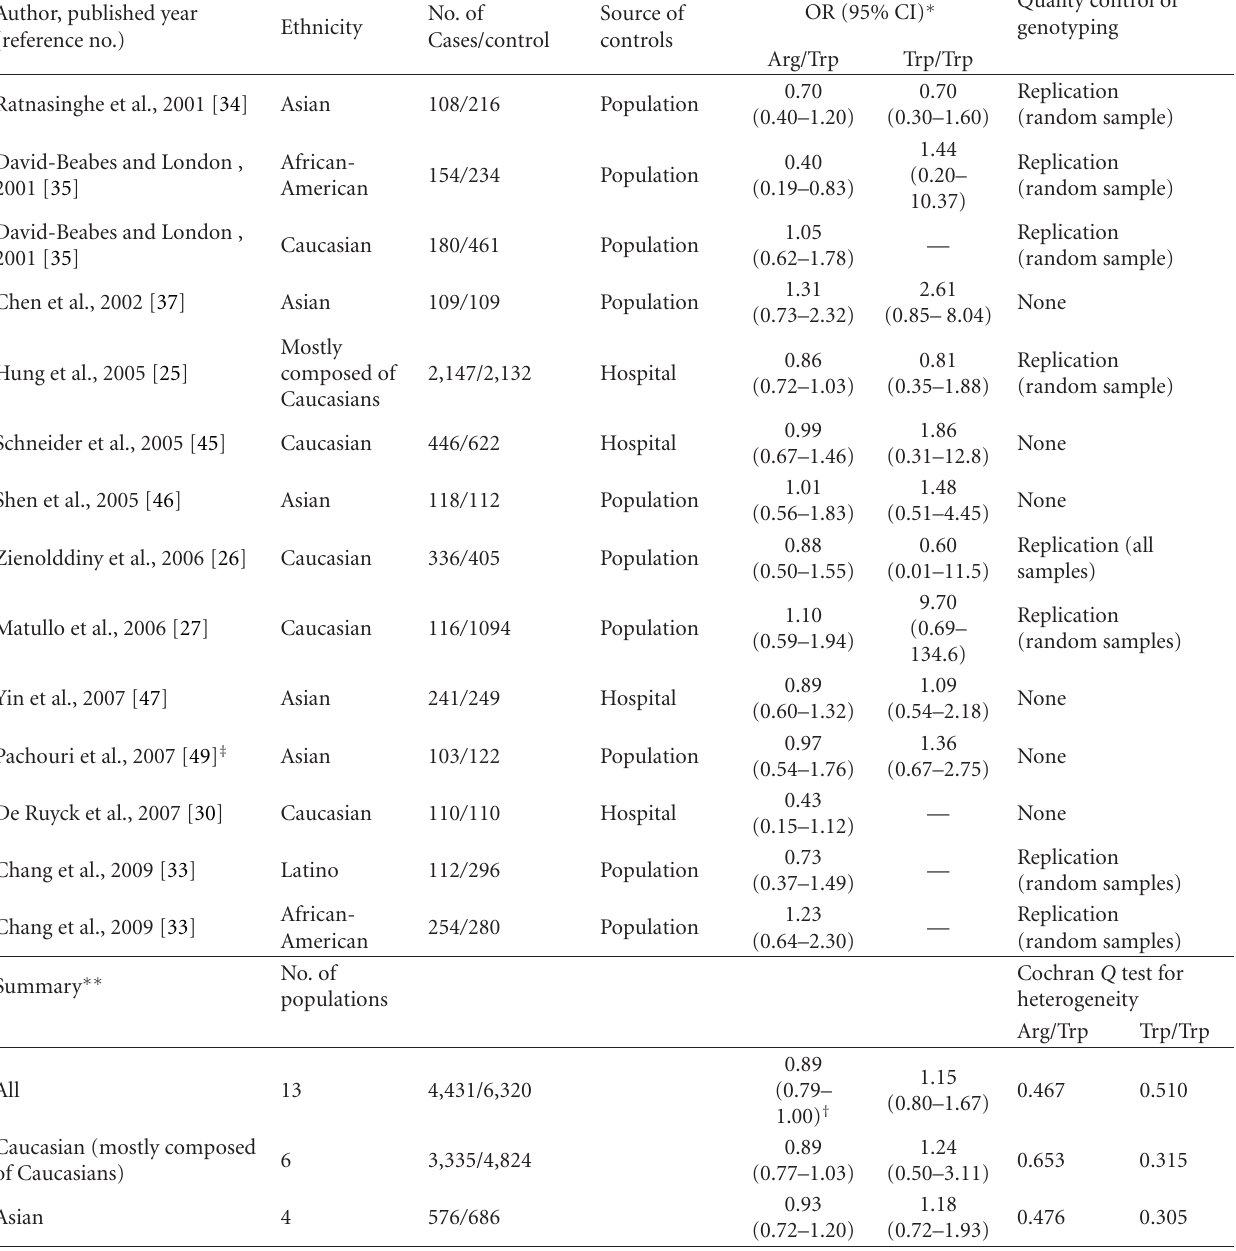
Table 4: Genetic polymorphisms in the BER pathway and lung cancer risk: XRCC 1 Arg194Trp